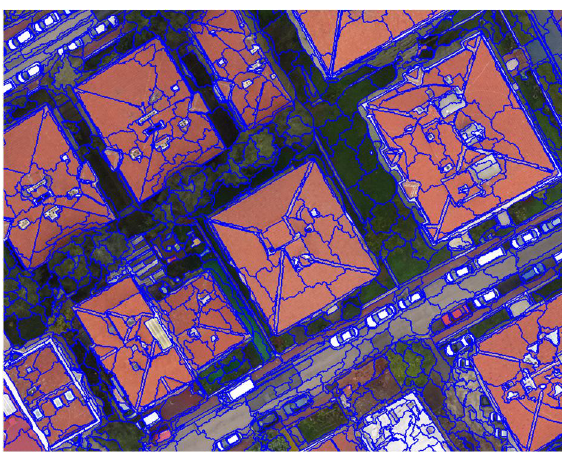
Figure 4. Created images objects with the MRS